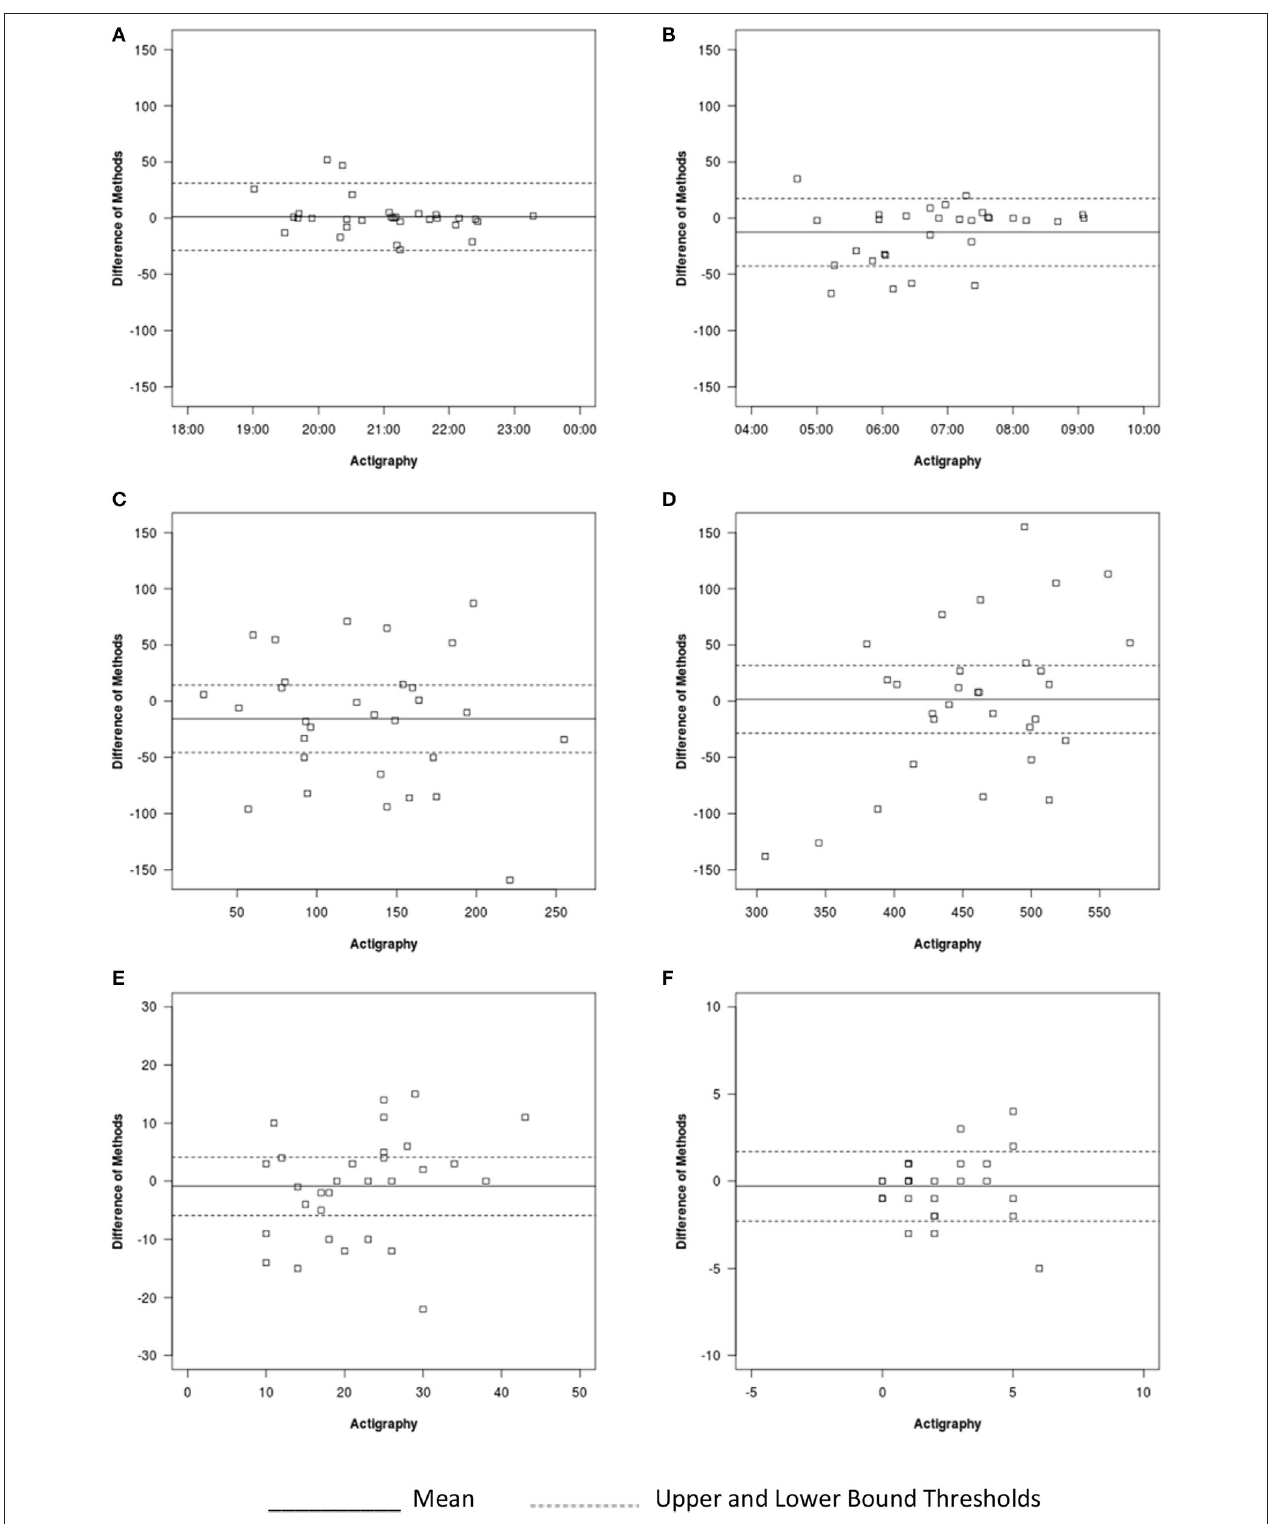
FIGURE 4 | Bland-Altman plots for auto-VSG and actigraphy for (A) sleep onset, (B) sleep offset, (C) WASO, (D) sleep duration, (E) number of minor wakings, and (F) number of major wakings.